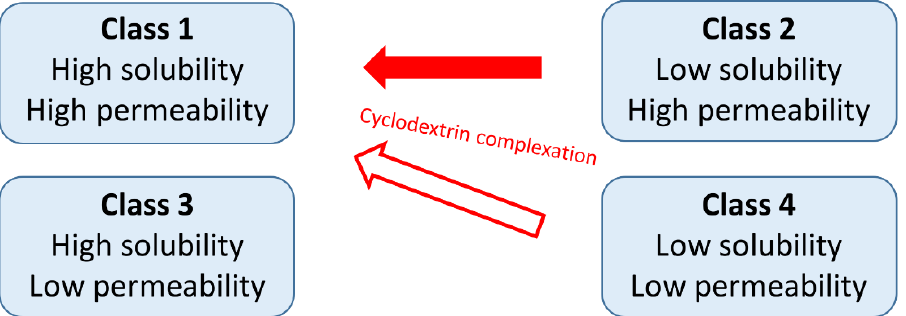
Figure 1. The relationship between the Biopharmaceutics Classification System and the effects of cyclodextrin complexation.